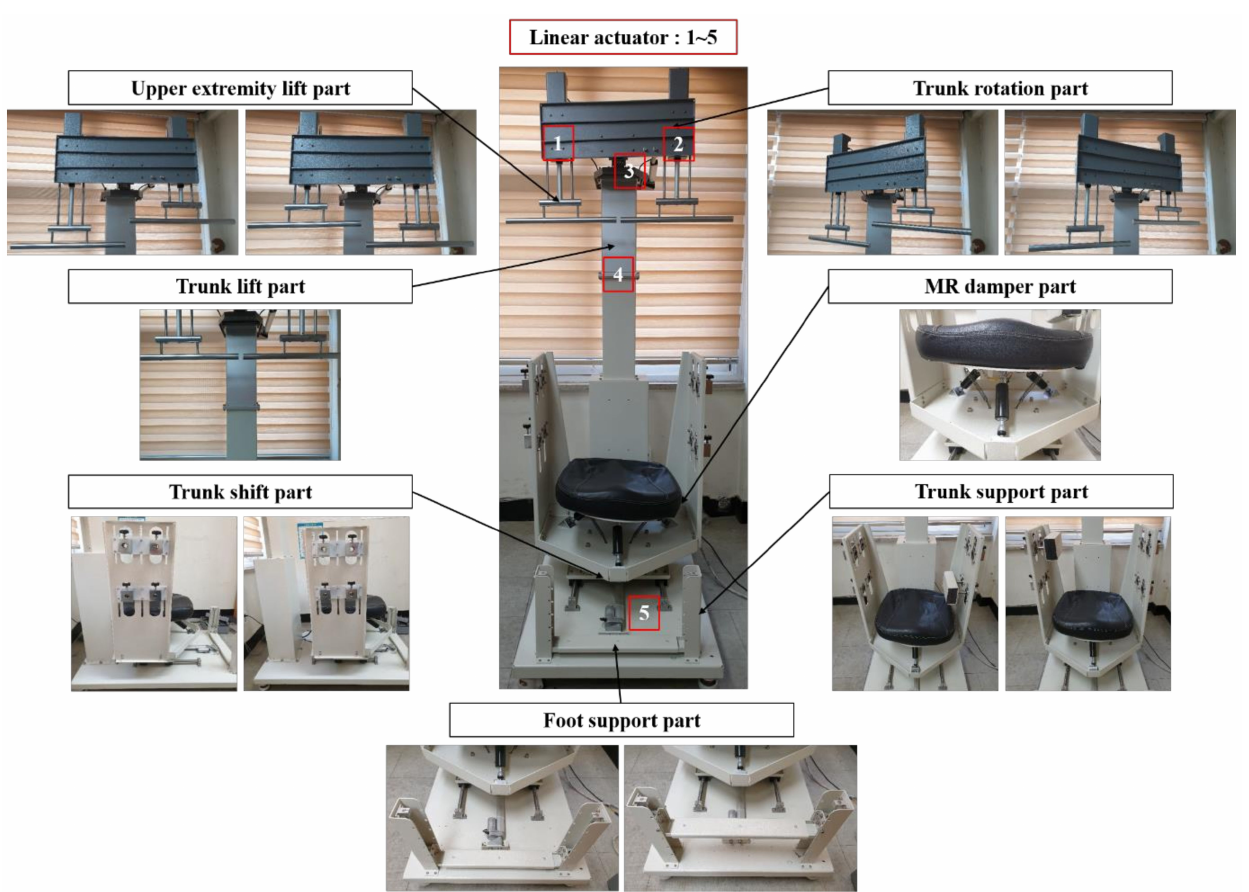
Figure 1. The rehabilitation exercise